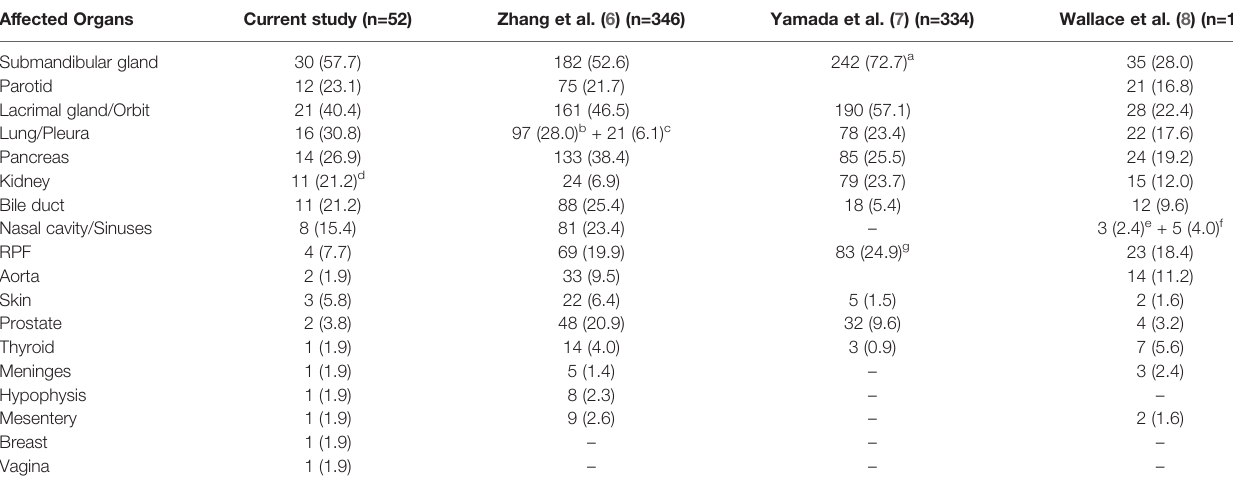
TABLE 2 | Comparisons of organ involvement in patients with IgG4-RD in different